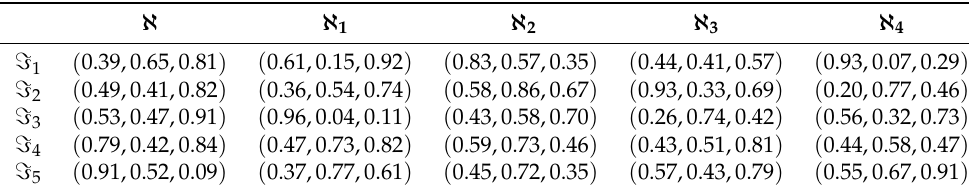
Table 1. Data in the form of FOFNs.